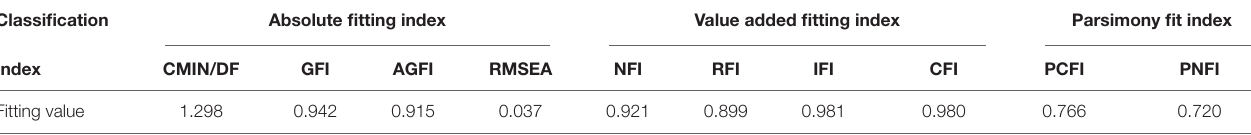
FIGURE 4 | Confirmatory factor analysis (CFA) model diagram. TABLE 6 | Fitting results of structural equation